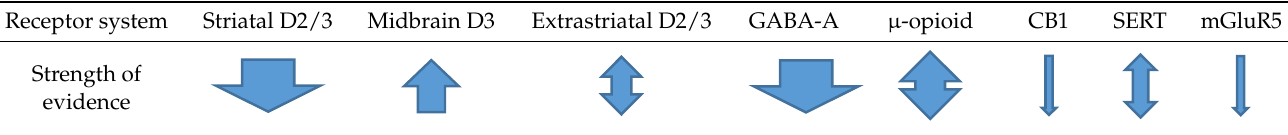
Thickness of arrow indicates the relative strength of evidence of research in the receptor system as assessed by the author based on studies reported in the chapter.